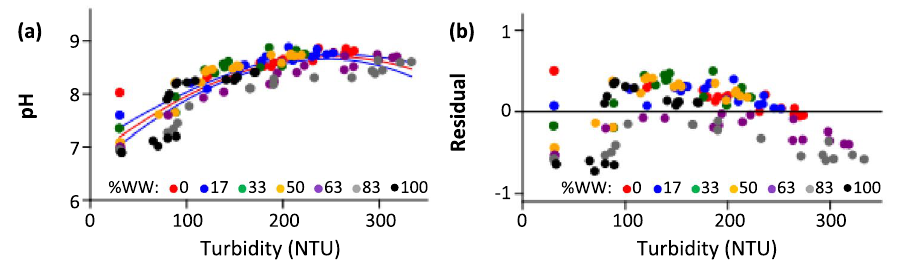
Figure 4. Integrating 126 bivariate data pooled from seven WW proportions used in Fig. 1 into single planes. ( a ) Scatter plot showing lack of linearity between pH and turbidity overall. Data can be model by the equation pH = 8.71*exp(− [(T − 250) 2 ]/[2*1.26E05]); 95% confidence interval limits included as blue lines. ( b ) Associated residual plot showing lack of randomness expected from a linear relationship between pH and turbidity at all %WW. Data corresponding to each WW proportion is